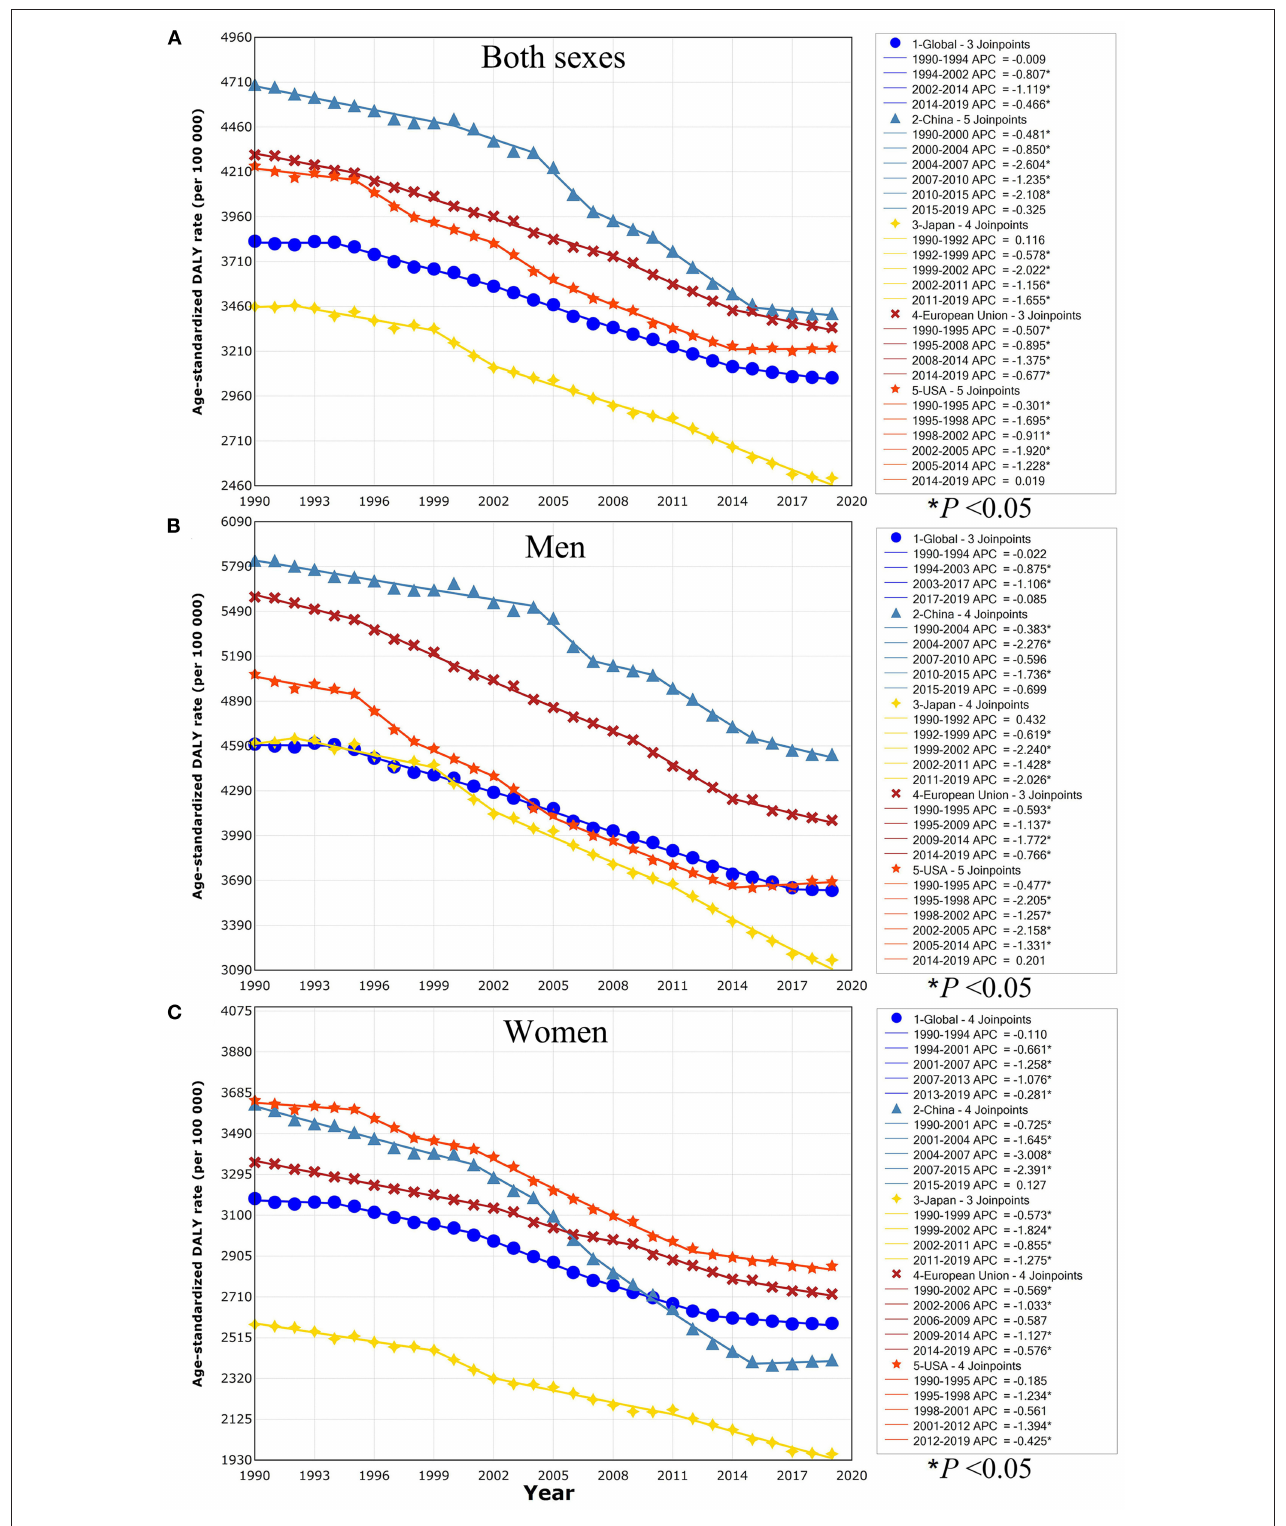
FIGURE 1 | Trends for the ASDR of overall neoplasms in the world, China, Japan, European Union, and USA from 1990 to 2019 calculated by joinpoint regression analyses. (A) Both sexes; (B) men; (C) women. ASDR, age-standardized disability-adjusted life-year rate; APC, annual percentage change. * P < 0.05 indicates a statistically significant change in trends (increase or